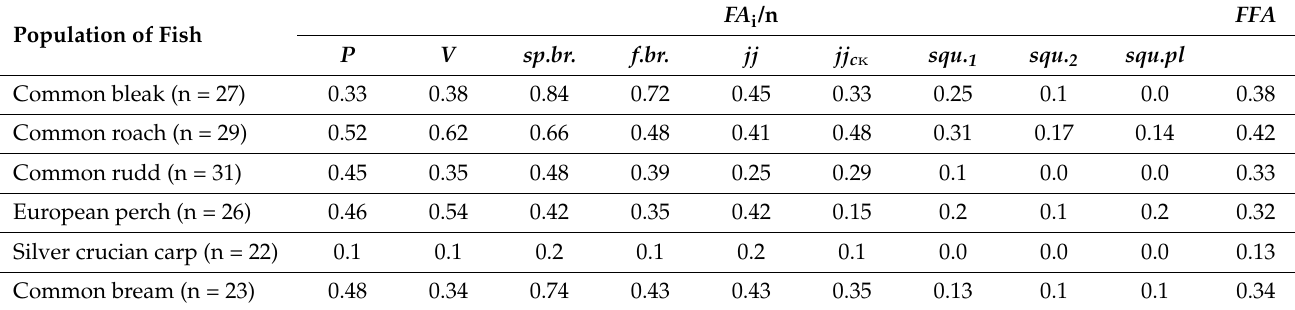
Table 3. The FFA for each studied fish population in the Sluch River at sampling site No. 1 ( p ≤ 0.05).